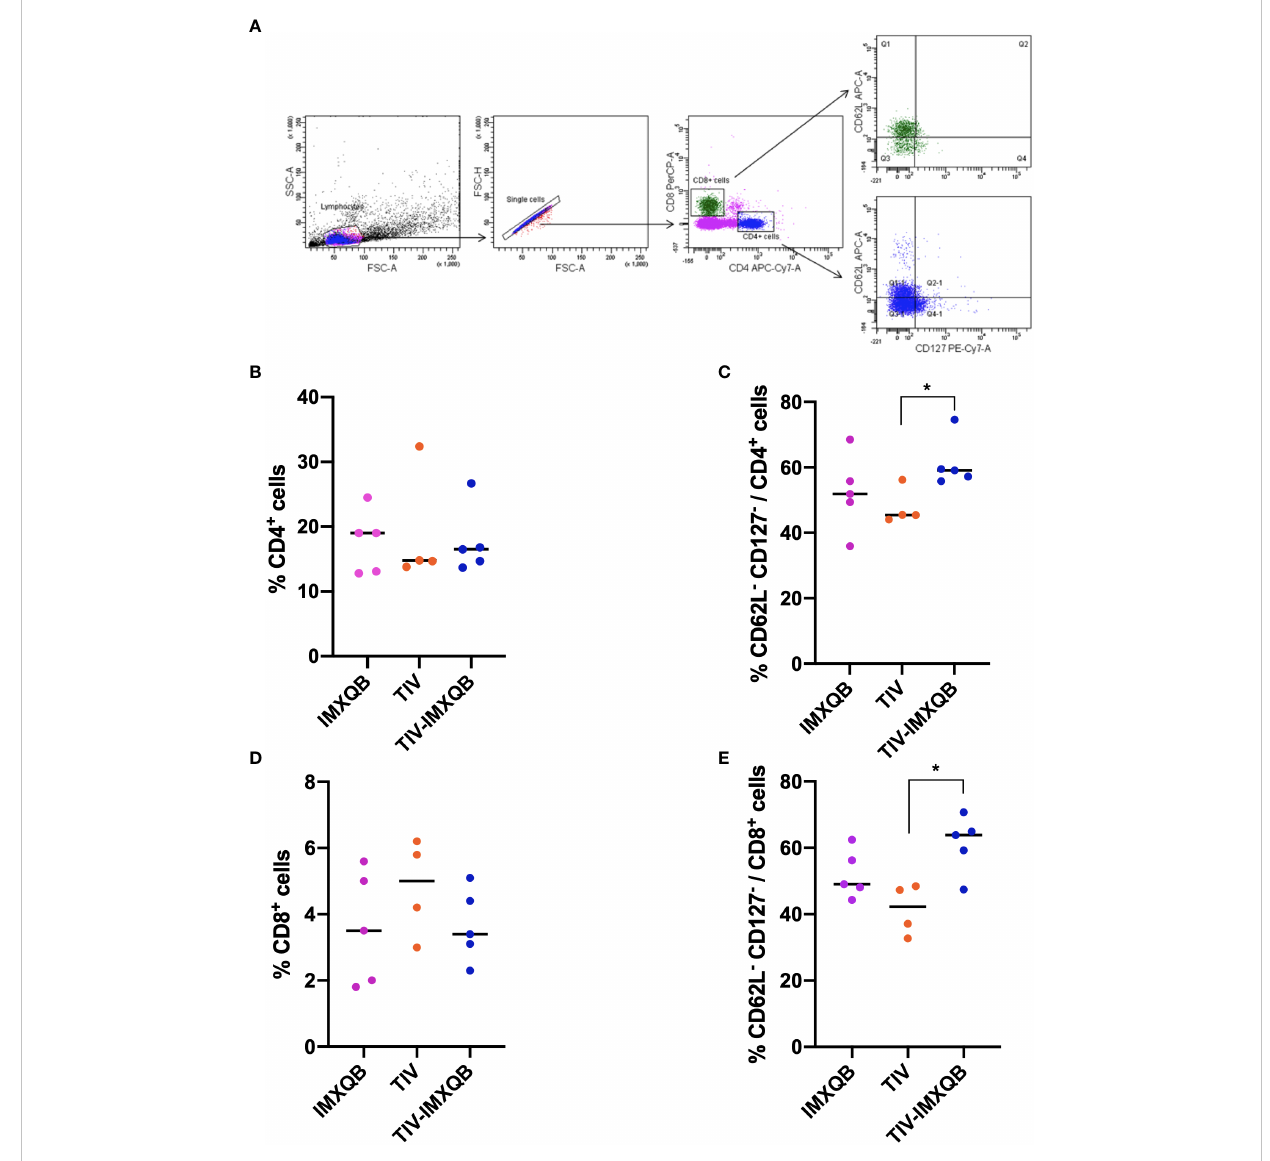
FIGURE 5 TIV-IMXQB adjuvanted in fl uenza vaccine recruits more effector-T cells than the unadjuvanted vaccine. CD1 female mice (n=5) were inoculated subcutaneously on days 0 (priming) and 14 (booster) with either the control formulation (IMXQB or trivalent in fl uenza vaccine (TIV) alone) or TIV- IMXQB. Recruitment of effector T cells (CD62L - CD127 - ) was assessed by fl ow cytometry. Splenocytes obtained on day 28 post primed were stained with the following surface-staining antibodies: CD4-APC-Cy7, CD8-PerCP, CD62L-APC, and CD127-PE-Cy7. (A) Gating strategy was performed. No differences were found in the recruitment of CD4 + (B) or CD8 + (D) T cells among groups. TIV-IMXQB formulation was able to promote higher recruitment of CD62L - CD127 - cells within CD4 + (C) and CD8 + (E) T cells than the unadjuvanted formulation (TIV). The median value is indicated by a line, and the dots indicate individual values. Statistical analyses were performed by a Mann – Whitney U -test ( t -test non-parametric) test comparing every group against the others. Statistically signi fi cant differences are indicated with stars: *(P < 0.05) and horizontal